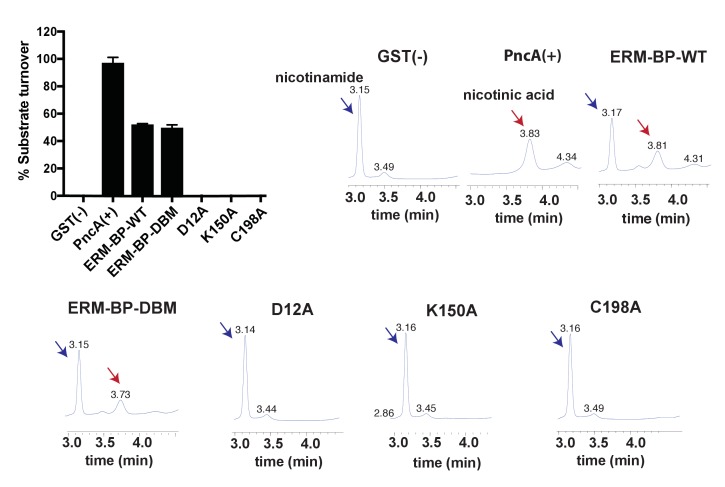
Enzymatic activity of ERM-BP-WT and mutants.The graph represents percentage of nicotinamide turn over into nicotinic acid by ERM-BP-WT and mutant recombinant proteins. Bacterial PncA was used as positive control and GST as a negative control. Data are mean ±s.d. (n = 3). The catalytic activities of the wild type (WT) ERM-BP and mutant recombinant proteins were determined by HPLC analysis. Bacterial nicotinamidase (PncA) was used as positive control with 100% conversion; GST was a negative control with 0% conversion. LC-traces are shown as a representative example from one experiment out of three independent experiments.